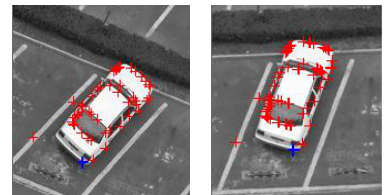
Figure 5 (b) matching result by improved algorithm, red cross for corresponding point, blue crosses for one pair of corresponding points